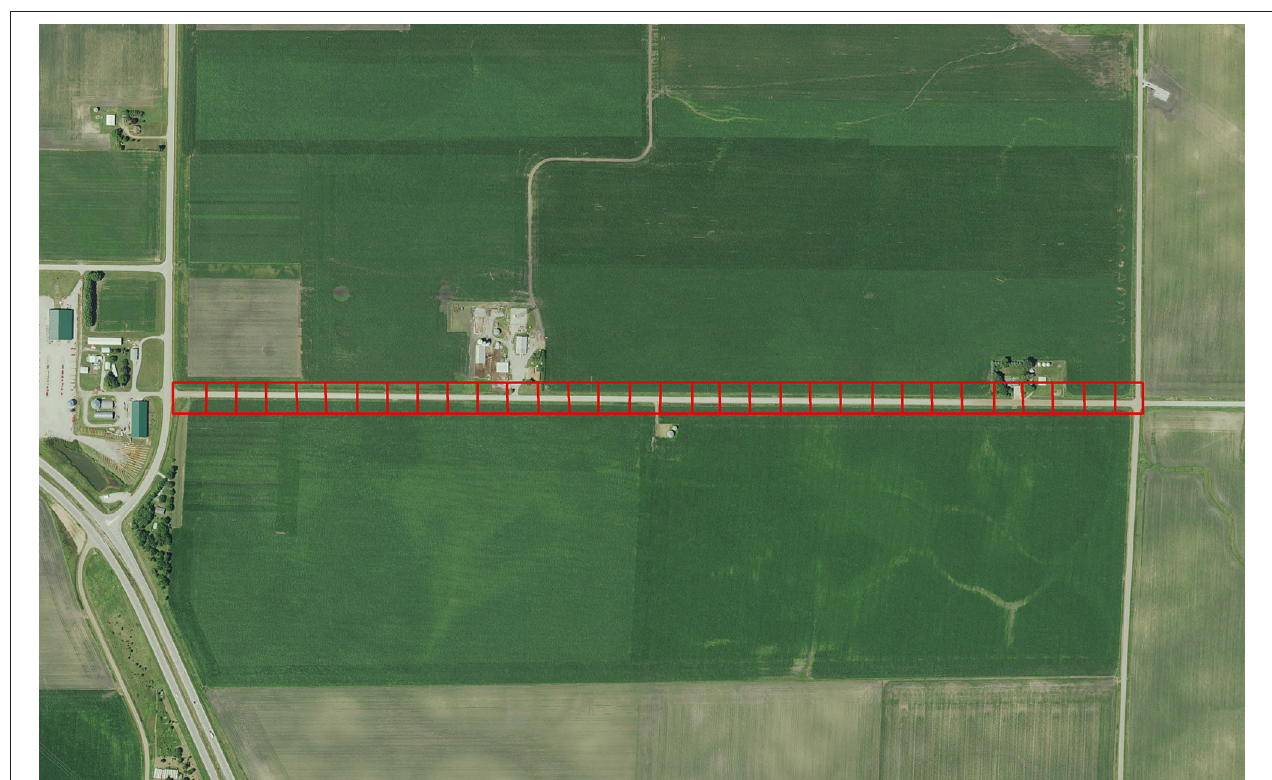
FIGURE 2 | The rural road in Boone County in which egg density data was collected by Blader (2018). Red squares (50m X 50m) outline patches in the agent-based model developed by Grant et al. (2018). Empirically-measured egg density for each patch is compared to predicted egg density to calibrate the